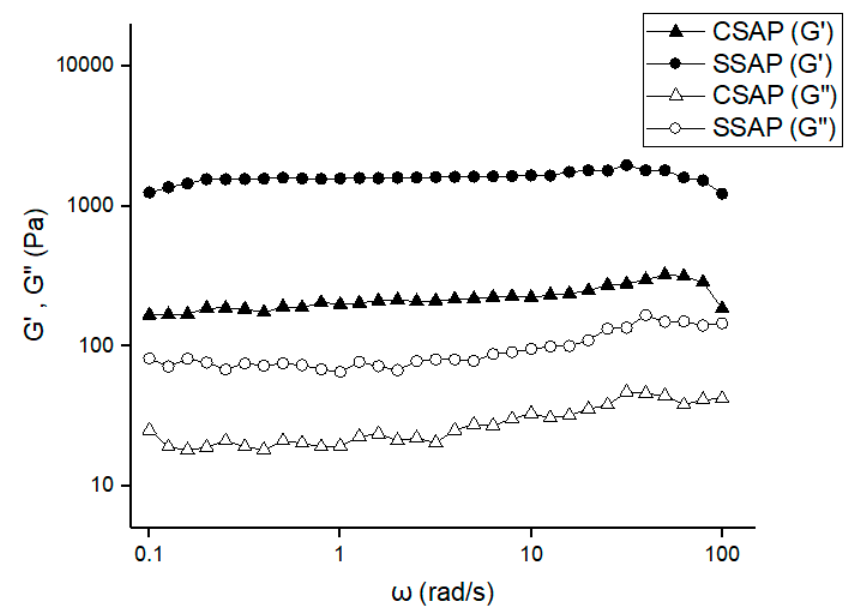
Figure 4. G’ and G” frequency of IC 2.5 VA CSAP and SSAP. Figure 4. G (cid:48) and G” frequency of IC 2.5 VA CSAP and SSAP.